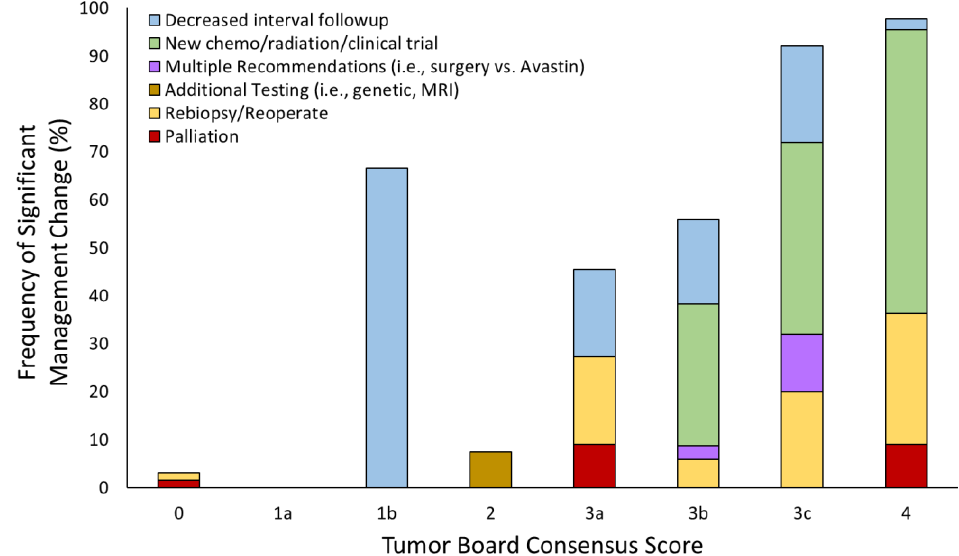
Figure 3. The percent changes in management recommended by tumor board based on the consensus score. The relative distributions of the specific changes recommended are shown as well. For those not shown, no management change was recommended.